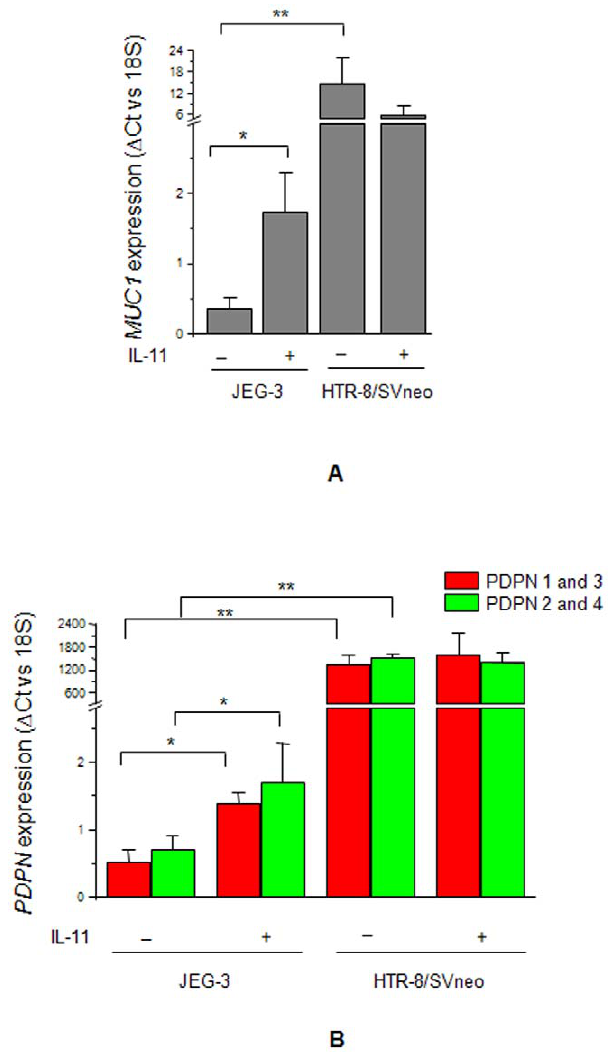
Figure 4. IL-11 mediated expression of MUC1 and PDPN in JEG- 3 and HTR-8/SVneo cells. Quantitative RT-PCR was done for the expression of MUC1 (Panel A) and PDPN (Panel B) as mentioned in Materials and Methods . Each bar represents the D Ct values after normalization with the 18S rRNA. The data is expressed as mean 6 SEM of 3 experiments performed in triplicates. *p , 0.05; **p ,